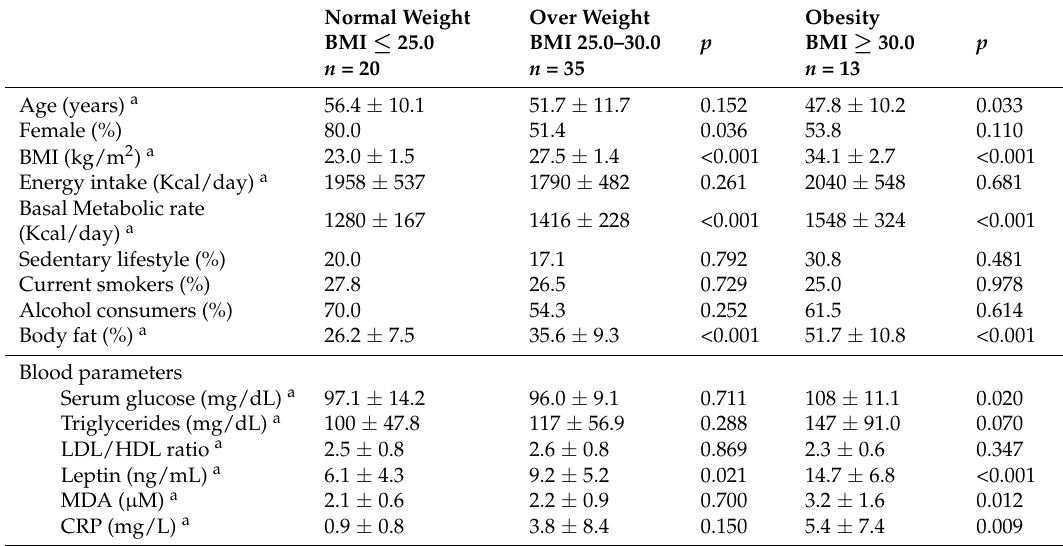
Table 2. General characteristics of the studied population according to